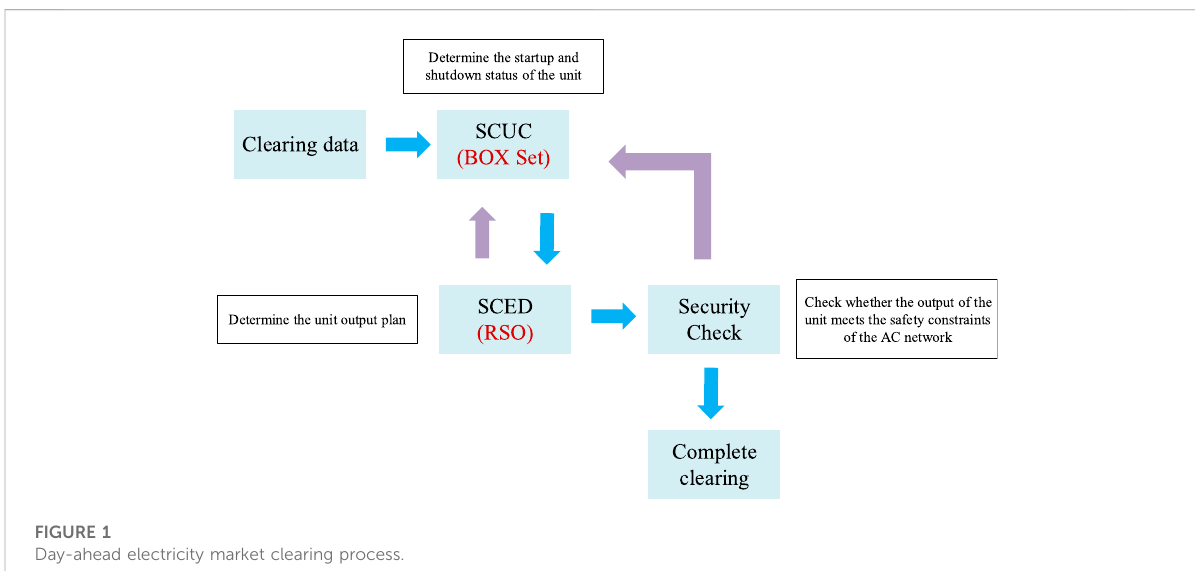
FIGURE 1 Day-ahead electricity market clearing